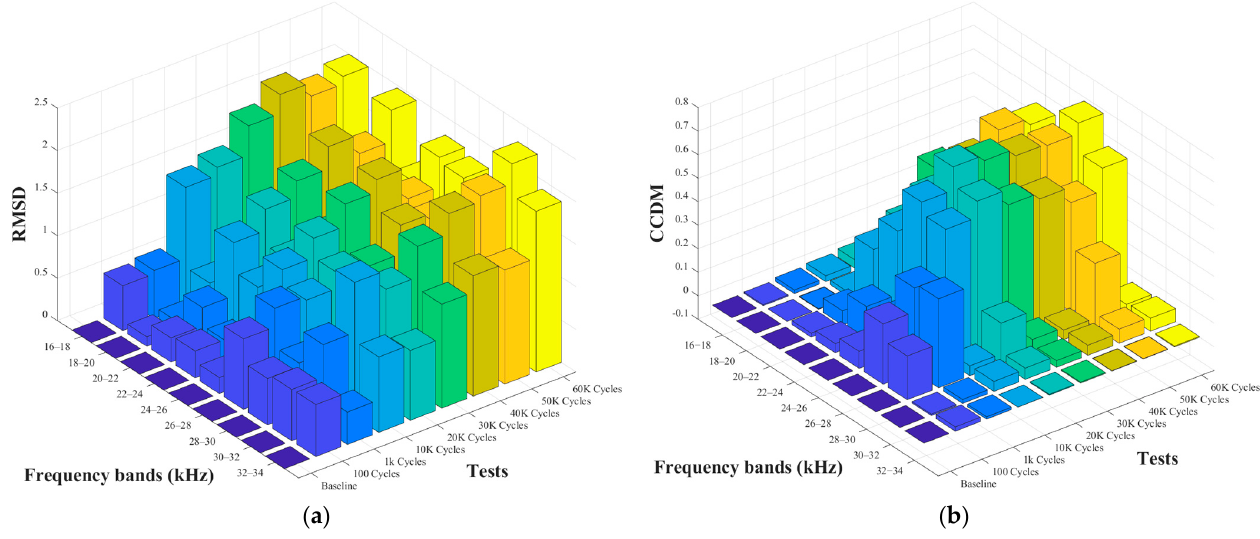
Figure 5. Damage indexes: ( a ) RMSD and ( b ) CCDM index for the 3–10 path with microcracks.